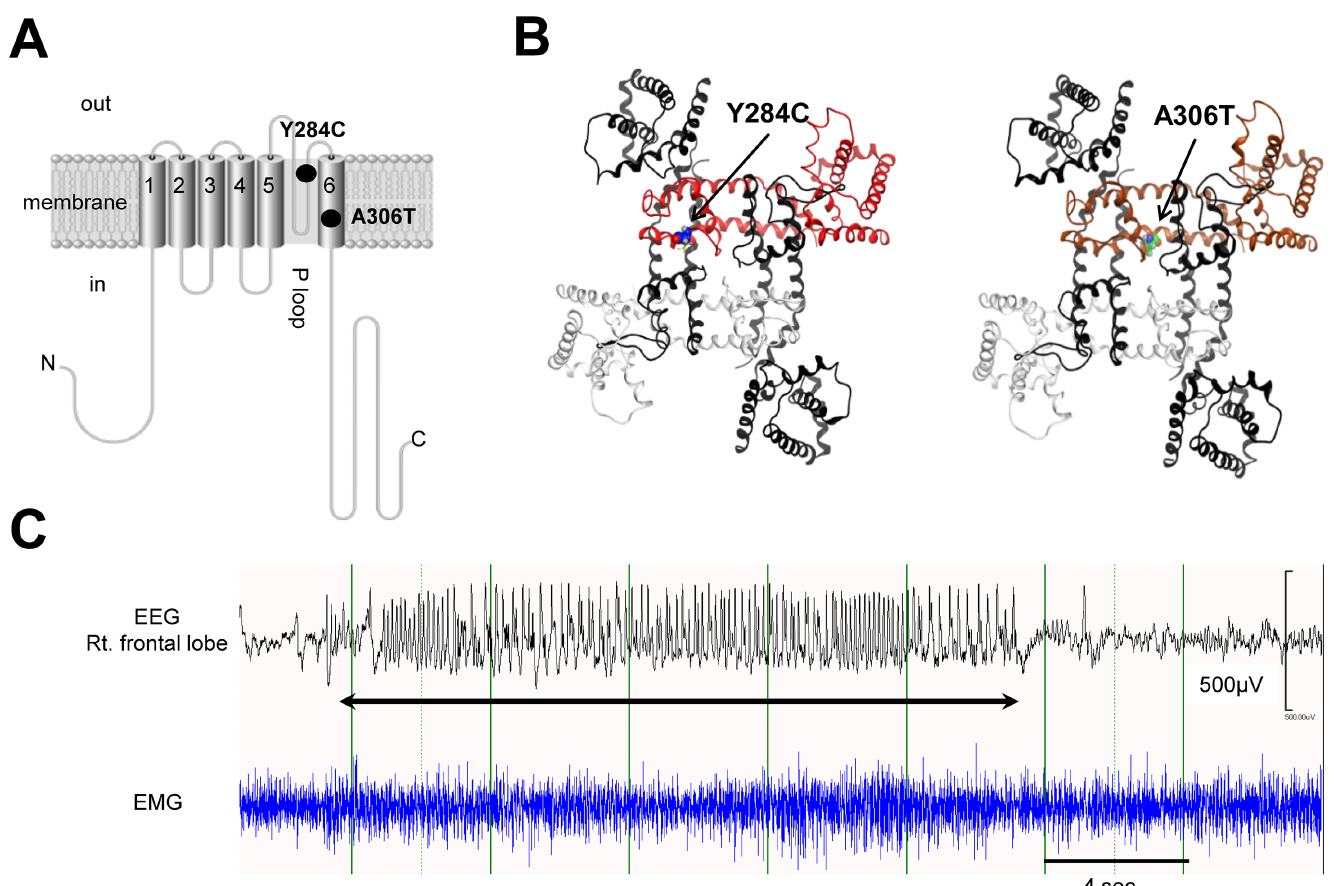
Fig 1. A. Molecular structure of the KCNQ2 subunit. The KCNQ2 subunit has six transmembrane domains (S1 – S6), of which the 4 th transmembrane domain (S6) functions as a voltage sensor, whereas a loop between the 5 th and 6 th transmembrane domains (S5 and S6, respectively) forms an ion pore along with three other counterpart subunits. In general, the KCNQ2 and KCNQ3 subunits form a heterotetrametric potassium channel, i.e., K v 7.2/K v 7.3. The K v 7.2/K v 7.3 channel generates M-currents that control the subthreshold excitability of the membrane. p.Tyr284 and p.Ala306, where the mutations examined in this study (Y284C and A306T) are located, occur at the outer mouth and the inner lining (S6) of the channel pore, respectively. B. Three dimensional images of the K v 7.2/K v 7.3 channels bearing Y284C and A306T. The images indicate the outer mouth of the channel seen from an extracellular position. Left : The heterotetrametric K v 7.2/K v 7.3 channel consists of two KCNQ3 subunits (Black), one normal KCNQ2 subunit (White), and the mutant KCNQ2 subunit (Red) bearing the Y284C mutation. The cysteine residue introduced by the Y284C mutation, which is indicated with balls, is located at the outer mouth of the channel. Right : The heterotetrametric K v 7.2/K v 7.3 channel consists of two KCNQ3 subunits, one normal KCNQ2 subunit, and one mutant KCNQ2 subunit bearing the A306T mutation. The tyrosine residue introduced by the A306T mutation, which is indicated with balls, is located at the inner lining of the channel pore. C. Spike burst. Top: A spike burst recorded during a kainic acid challenge test on an electroencephalogram (EEG) is indicated with a double sided arrow Bottom: A simultaneous electromyogram (EMG) recording. A spike burst is a cluster of high-amplitude and high frequency spikes, each of which lasts a few seconds to several